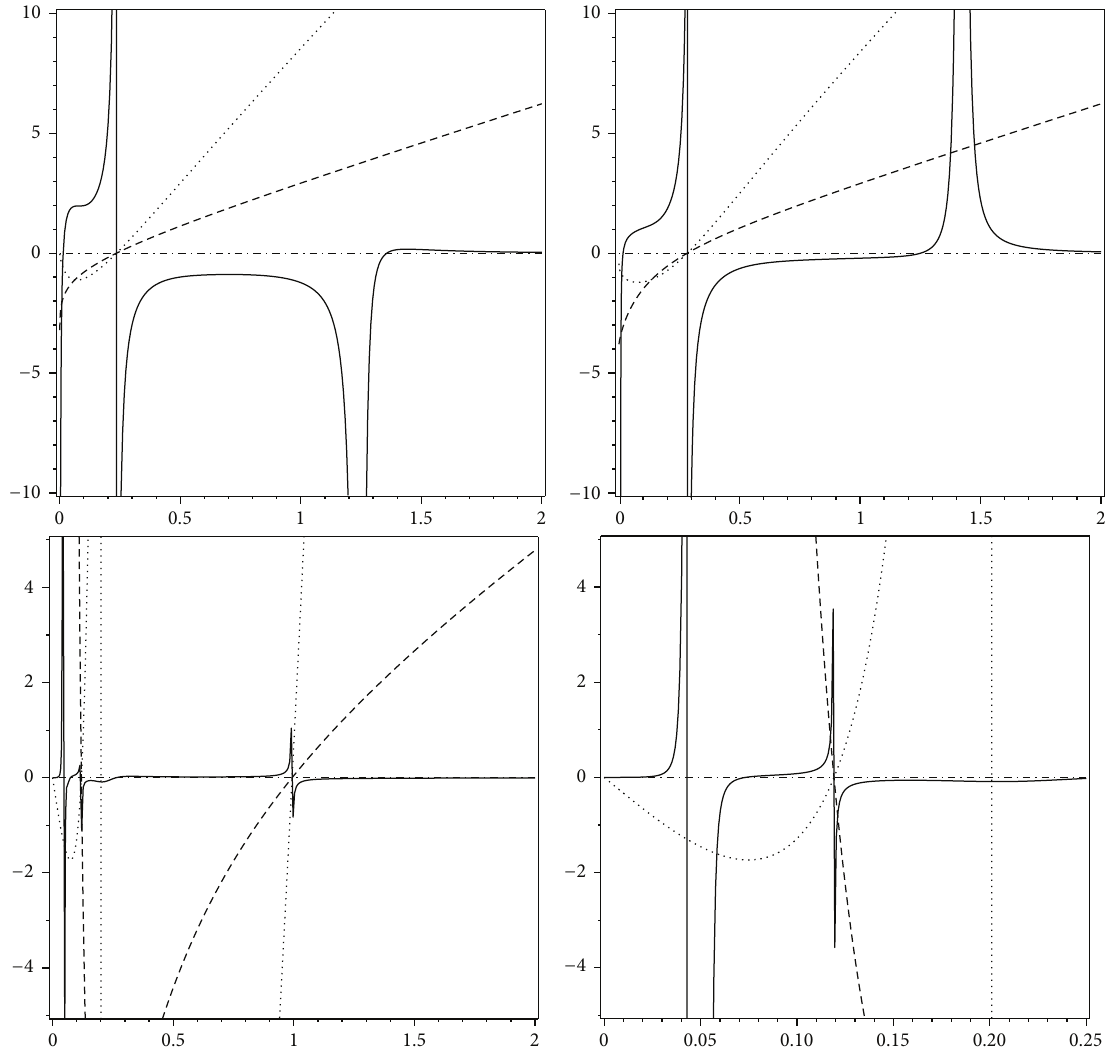
Figure 2: Ruppeiner Ricci scalar (solid line), heat capacity (dotted line), and temperature (dashed line) versus 𝑆 for 𝑙 = 1. HNED model (up-left panel) and SNED model (up-right panel): 𝑞 = 0 . 3, 𝛽 = 1. CNED model (down-left panel) and CNED model (down-right panel): 𝑞 = 1, 𝛼 = 0 . 007 (different